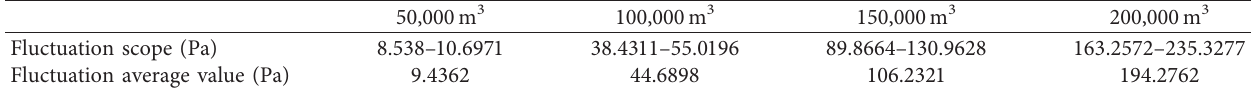
Figure 10: Dynamic pressure curve of sensor head end with flap angle at 80 o . (a) 50,000m 3 . (b) 100,000 m 3 . (c) 150,000 m 3 . (d) 200,000 m 3 Table 5: Dynamic pressure fluctuation scope at 10 ° flap angle.